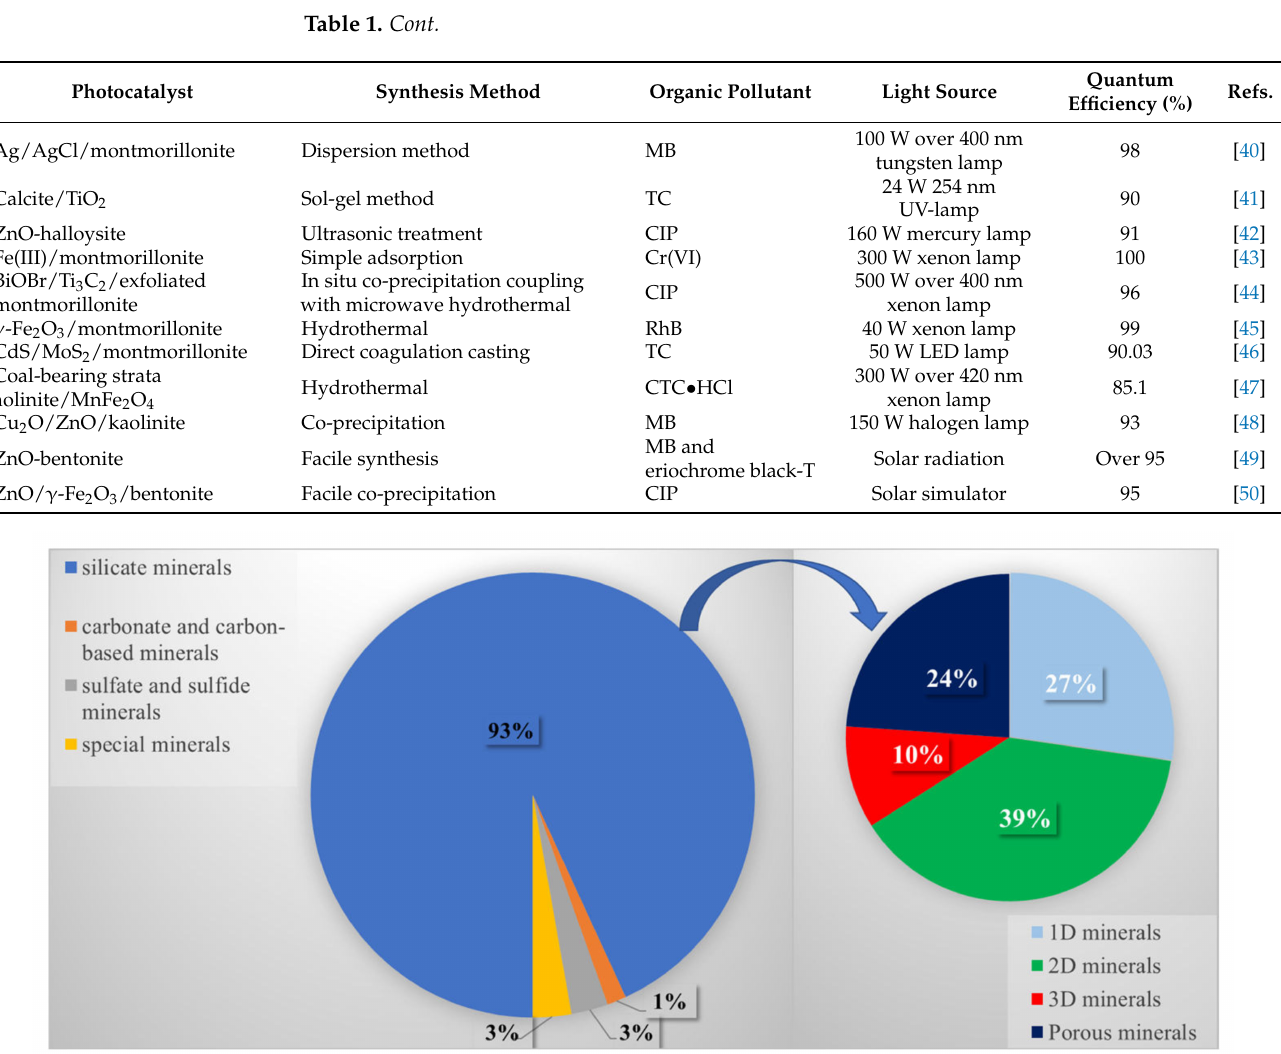
Figure 1. Representation of different natural minerals in